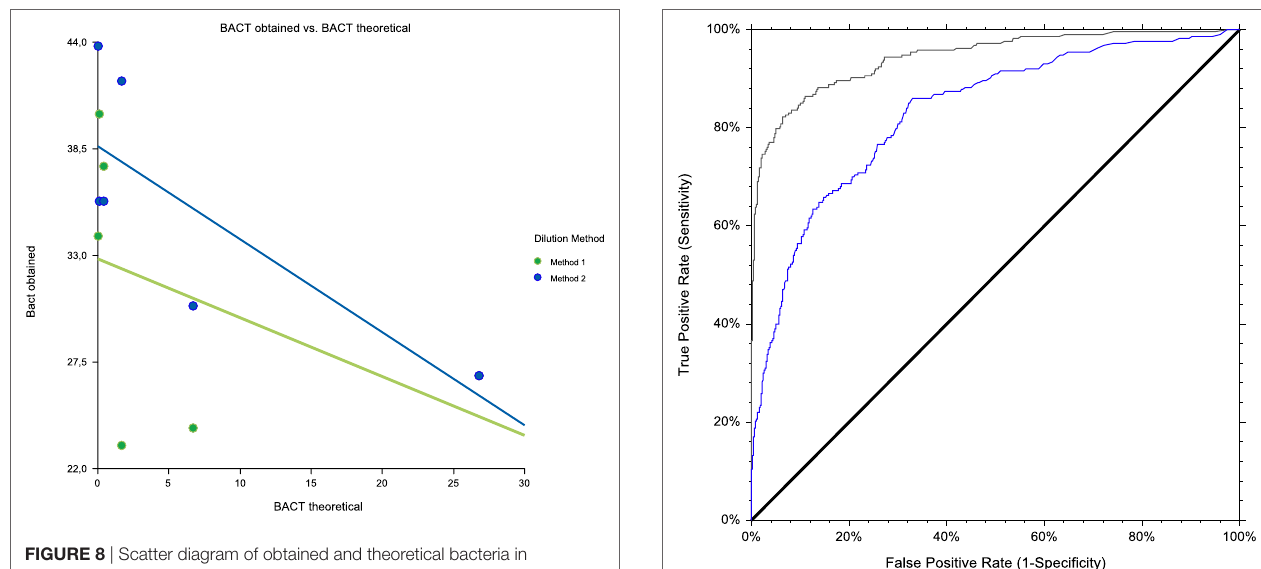
FIgURe 8 | Scatter diagram of obtained and theoretical bacteria in sample 2.